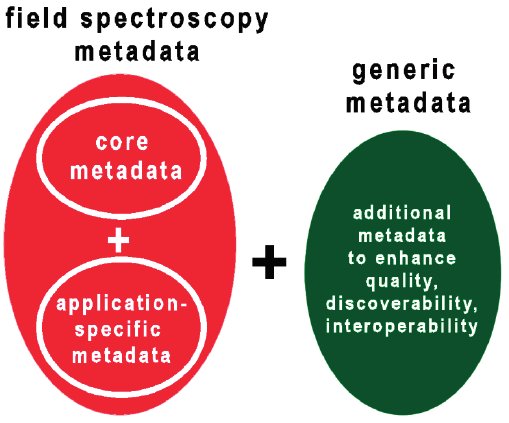
Figure 2. Profile of an application-specific field spectroscopy